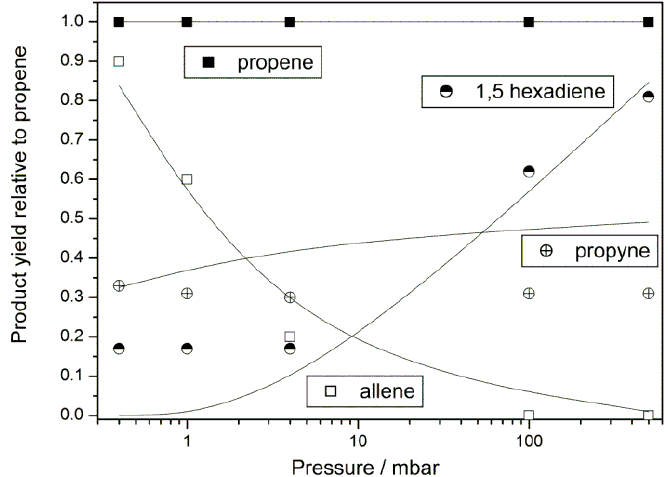
Figure 3. Pressure dependent formation of the products 1,5-hexadiene, allene, propene and propyne between 0.4 and 500 mbar. Precursor allyl bromide, p(C gas Ar, T = 296 ± 1 K. Symbols show experimental data points, lines show the result of a kinetic simulation using the mechanism of Table 2. The initial concentration of allyl radicals (1 × 10 − 9 mol/cm 3 ) in the simulation was estimated from the photolysis laser fluence and the consumption of allyl bromide per 193 nm excimer laser pulse assuming a quantum yield of 1 for the allyl + bromine atom channel.